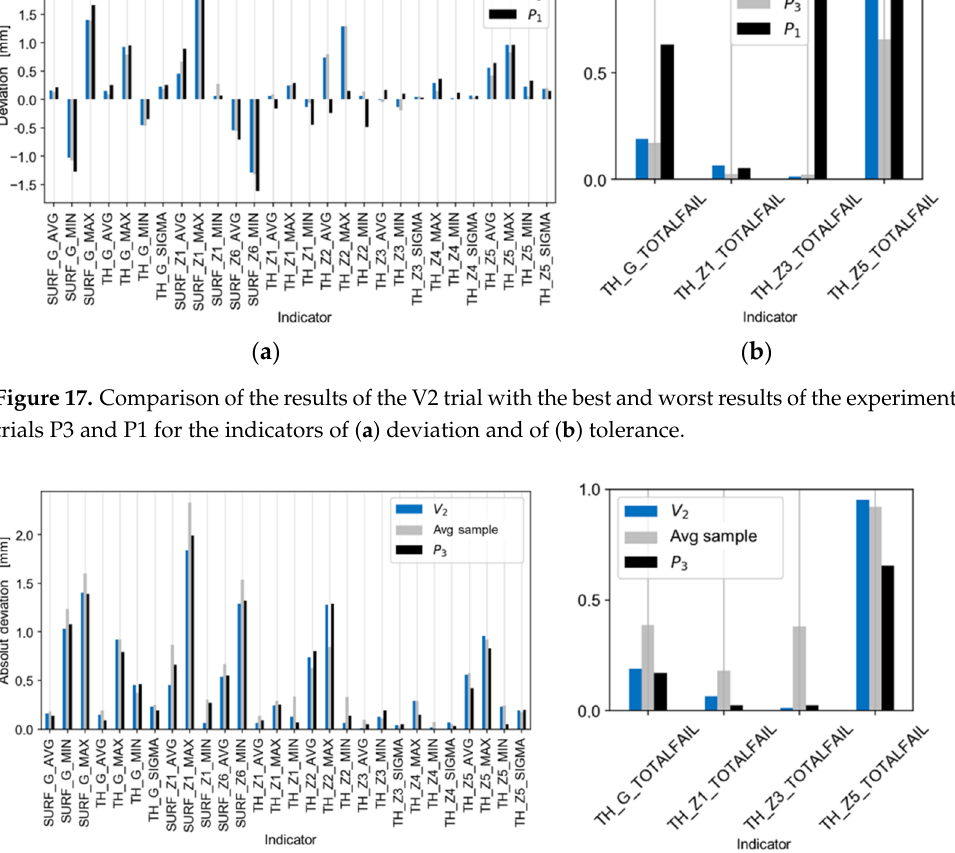
Figure 18. Comparison of the absolute deviations of the results of the V2 trial with the absolute best